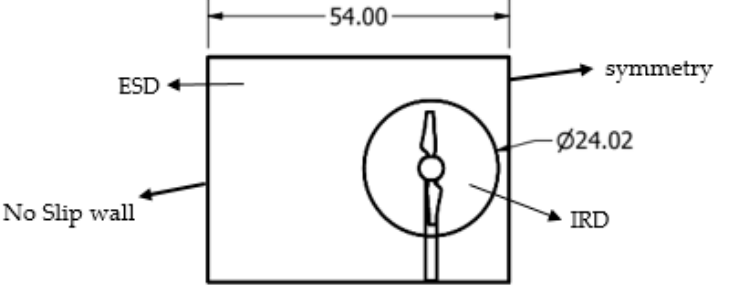
Figure 2. Front view of computational domain with External Stationary and Internal Rotating Domain .